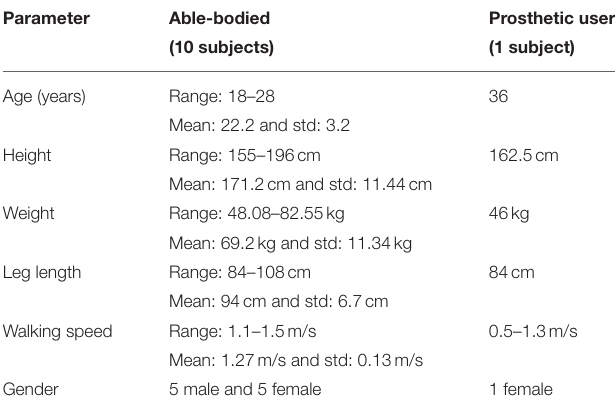
(Edgewood, NY) motion capture system, 6 ◦ of freedom